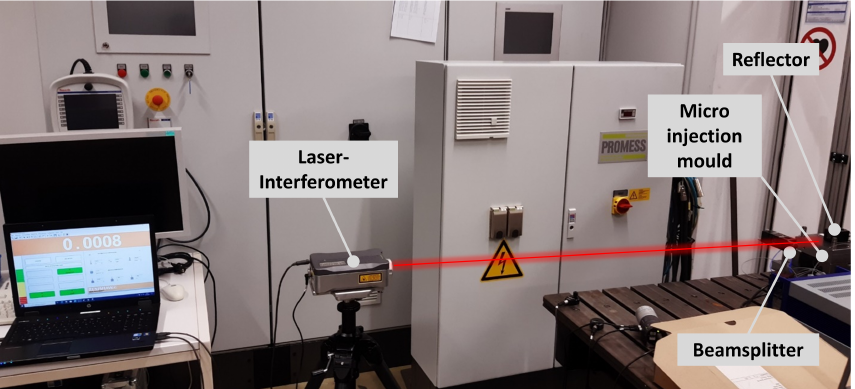
Figure 10. Set-up for calibration measurements of the mechatronic actuator. A mirror was mounted on the device, and its position was measured with a laser interferometer. By splitting the interferometer beam into two beams, the measurement could be made in the x and y directions without moving the device.